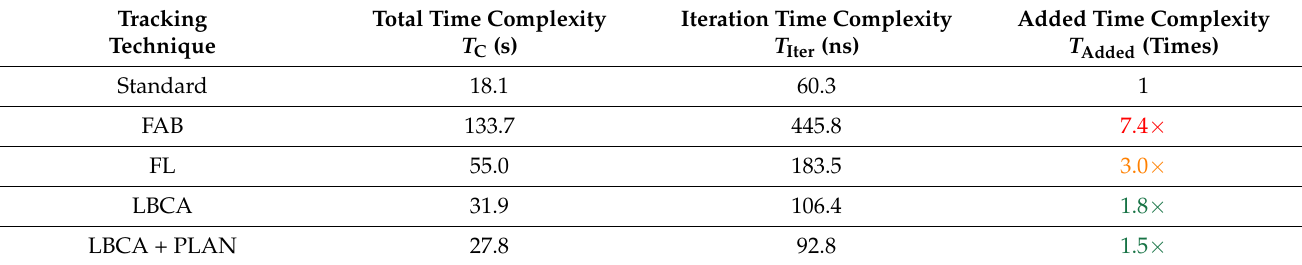
Table 3. Time complexity of the adaptive loop-bandwidth tracking techniques, 3 × 10 8